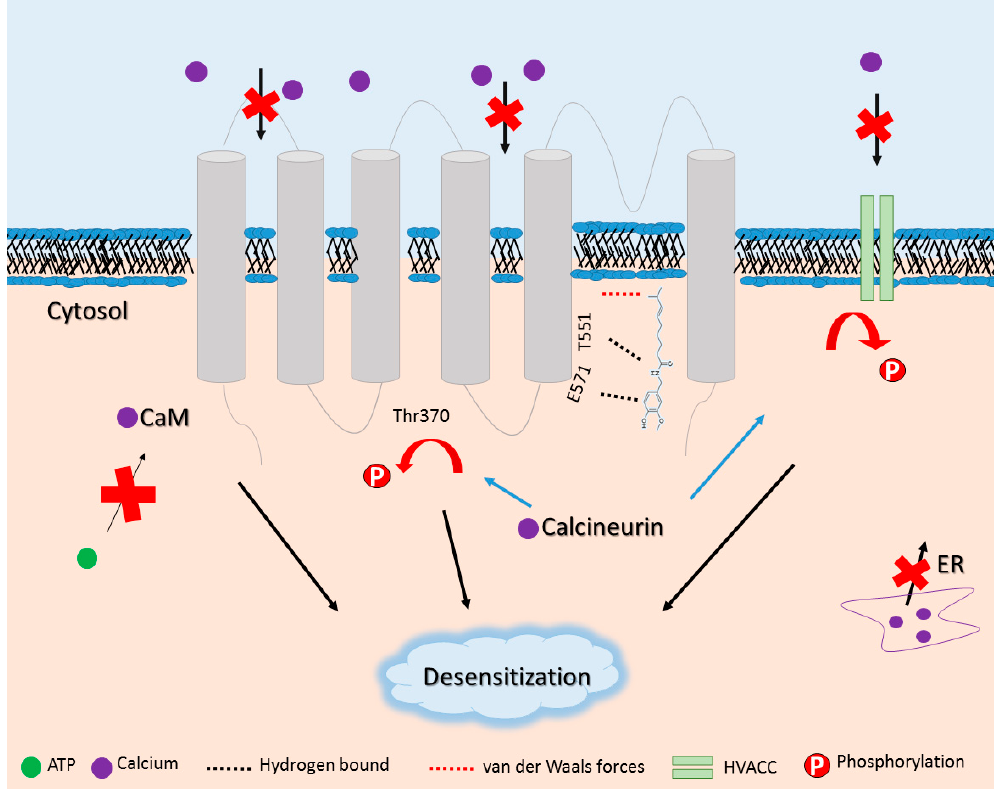
Figure 3. Mechanisms of capsaicin-TRPV1 interaction and desensitization. Capsaicin bounds to TRPV1